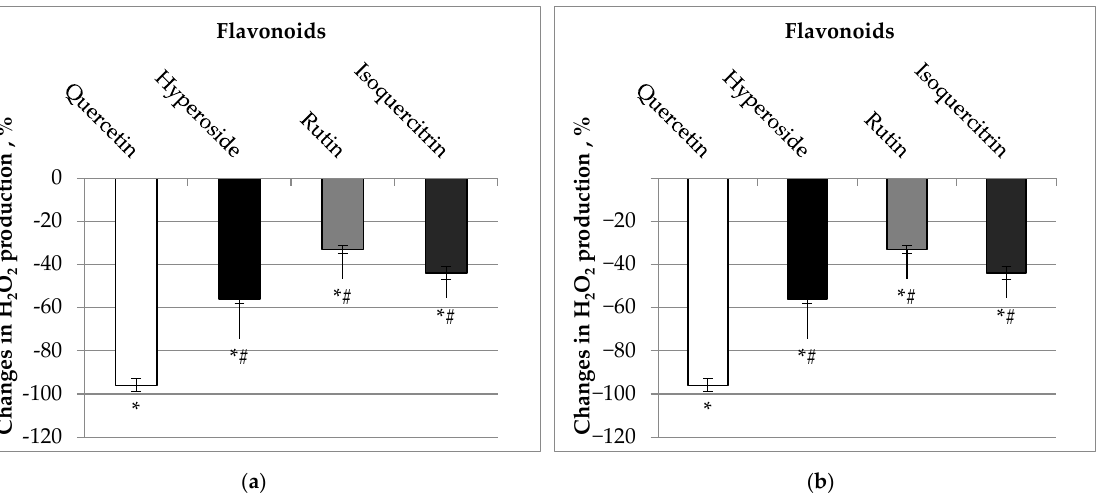
Figure 5. (a) Effect of 10 µM of flavonoids on mitochondrial production of H 2 O 2 . (b) Effect of 30 µM of flavonoids on mitochondrial production of H 2 O 2 . Mitochondrial production of H 2 O 2 was measured as described in Material and Methods. * Statistically significant difference ( p < 0.05) compared to control (without flavonoids). The effect was calculated according to Formula (4). *# Statistically significant difference ( p < 0.05) compared to quercetin-group.